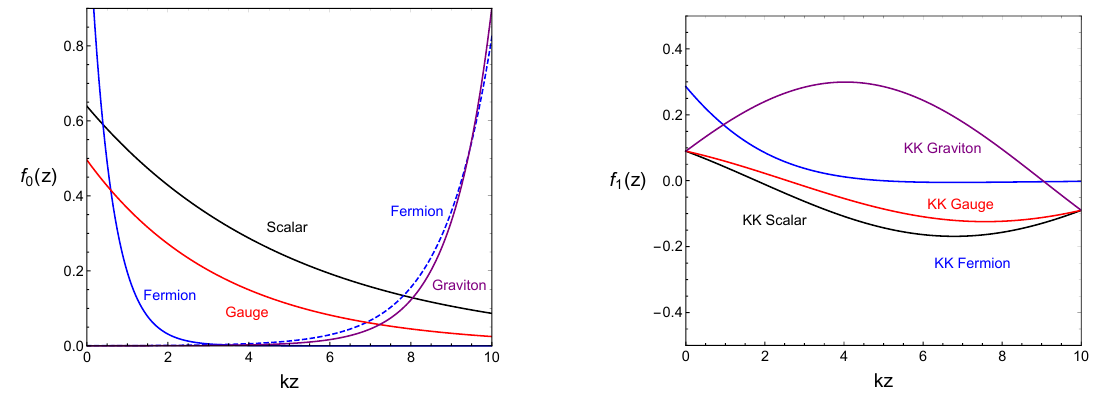
Figure 1 . (Left) The bulk pro(cid:12)les of zero modes of bulk (cid:12)elds. (Right) The bulk pro(cid:12)les of the (cid:12)rst KK modes of bulk (cid:12)elds. The wave functions for scalar, left-handed fermion, gauge boson and graviton are shown in black, (dashed) blue, red and purple lines, respectively. We took the bulk mass parameters, (cid:23) = (cid:6) 2, for solid and dashed blue lines, and the dilaton couplings, c = (cid:0) 0 : 5 for scalar and fermion, and a = (cid:0) 0 : 3 for gauge boson, and kz c =